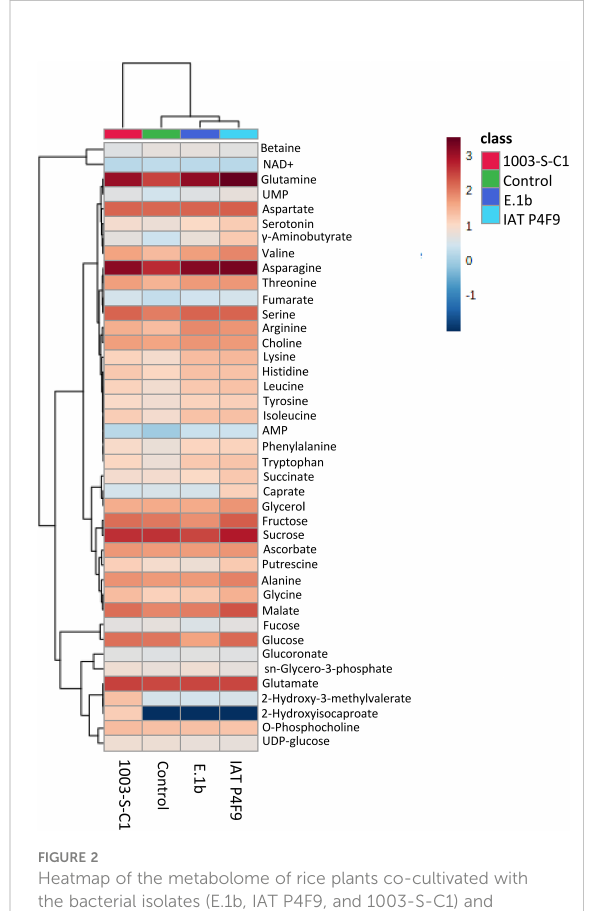
FIGURE 2 Heatmap of the metabolome of rice plants co-cultivated with the bacterial isolates (E.1b, IAT P4F9, and 1003-S-C1) and control plants (cultivated without bacteria). Columns represent each treatment and rows represent the different metabolites identi fi ed. The color code indicates the abundance of each metabolite (blue = low abundance; red = high abundance) based on the average of the Log 10 -transformed values (concentrations determined based on the reference signal of 0.5 mM TMSP-d 4 ) ( n = 4). The darkest blue indicates that the metabolite was not identi fi ed in plants subjected to the respective